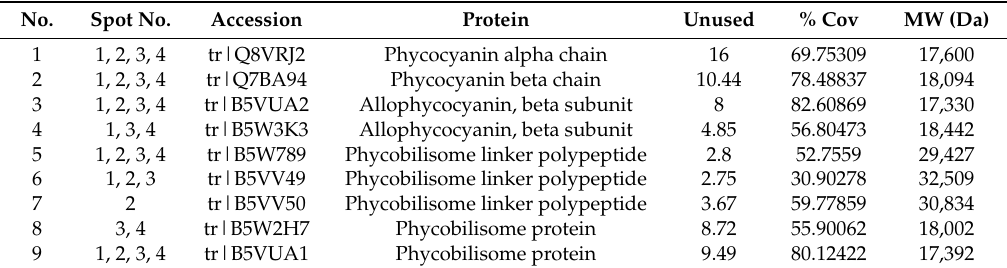
Table 2. Results of different protein spots identified by MALDI-MS/MS.